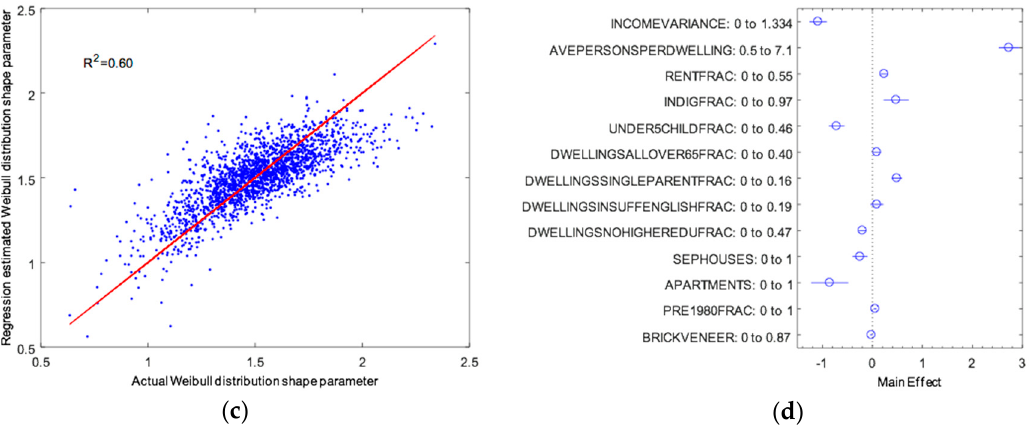
Figure 3. ( a,c ) Regression fits of Weibull distribution scale parameter and shape parameter for distributions of annual energy consumption for Statistical Area Level 2 (SA2) regions across Australia; ( b,d ) Comparison of relative main effects sizes of significant regression predictors in the fitted models for scale parameter and shape parameter.